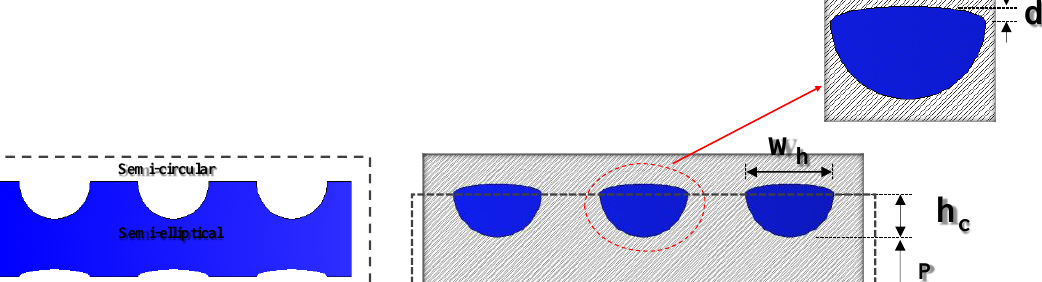
Figure 1. Cross-section of the printed circuit heat exchanger (PCHE) circuit ( a ) common cross flow section ( b ) improved with the additional elliptical upper channel.